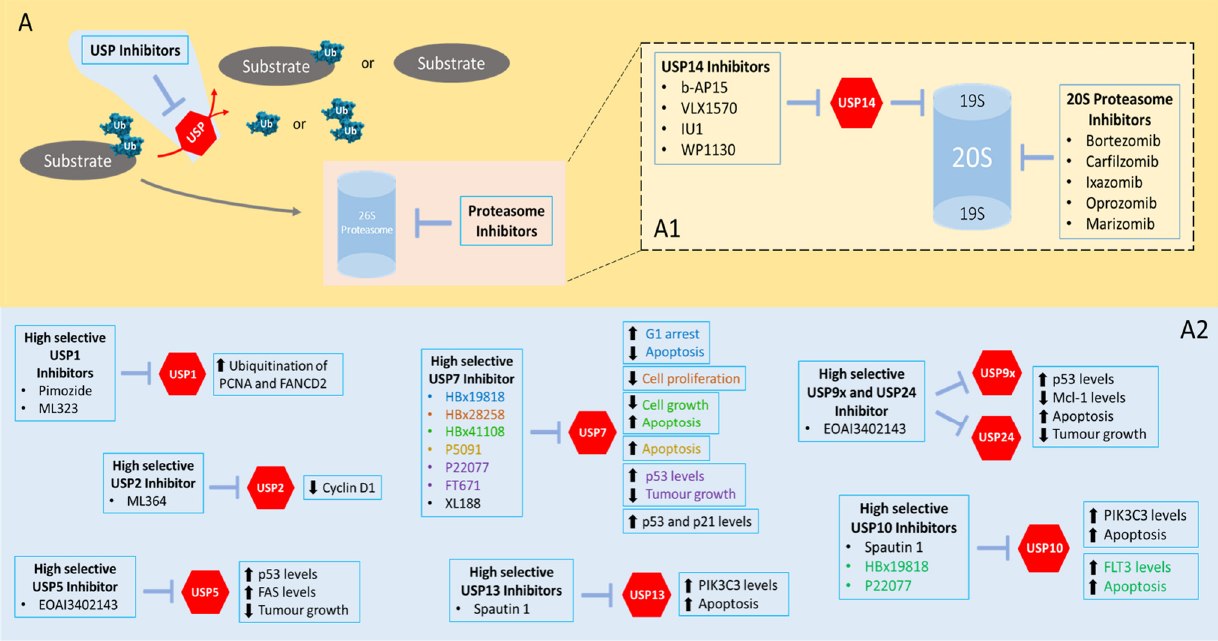
Figure 3. Interaction of USP inhibitors in the ubiquitin–proteasome pathway and cellular consequences. ( A ) A schematic representation about the role of USPs in the ubiquitin–proteasome pathway (image with orange and light pink background) and USP inhibitors (image with light blue background). ( A1 ) USP14 acts as a regulator of the 26S proteasome, due to inhibiting the 19S subunit. USP14 can be inhibited by four different inhibitors: b-AP15, VLX1570, IU1 and WP1130. ( A2 ) Cellular consequences of specific inhibition of some USPs with inhibitors only described as USP inhibitors. (Note: the text colors serve to help the reader to associate the inhibitor with its respective cellular consequence.).